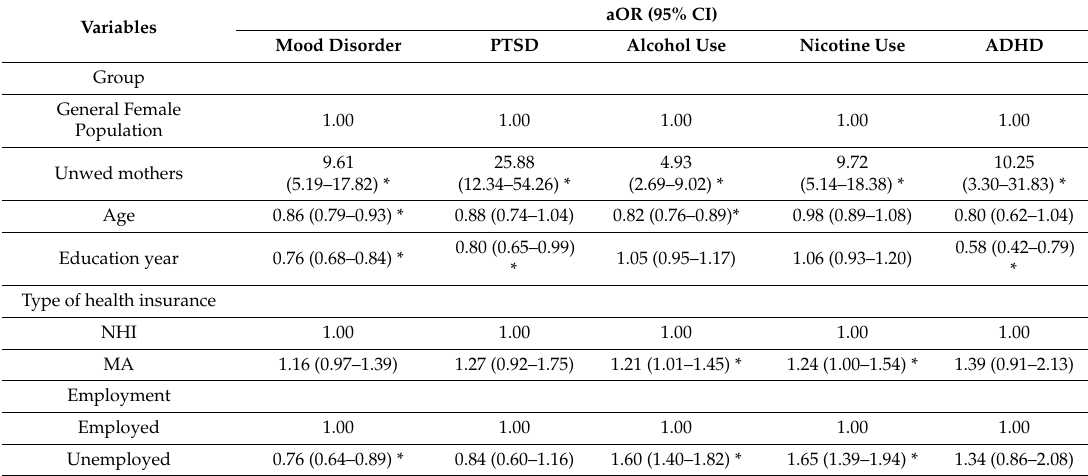
Table 3. ORs from multiple logistic regression analysis of the probability of psychiatric disorder.